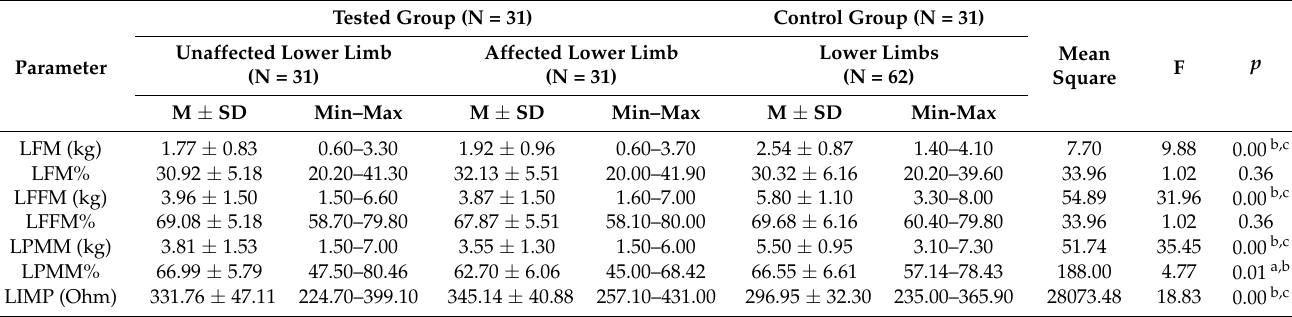
Table 5. One-way analysis of variance model.